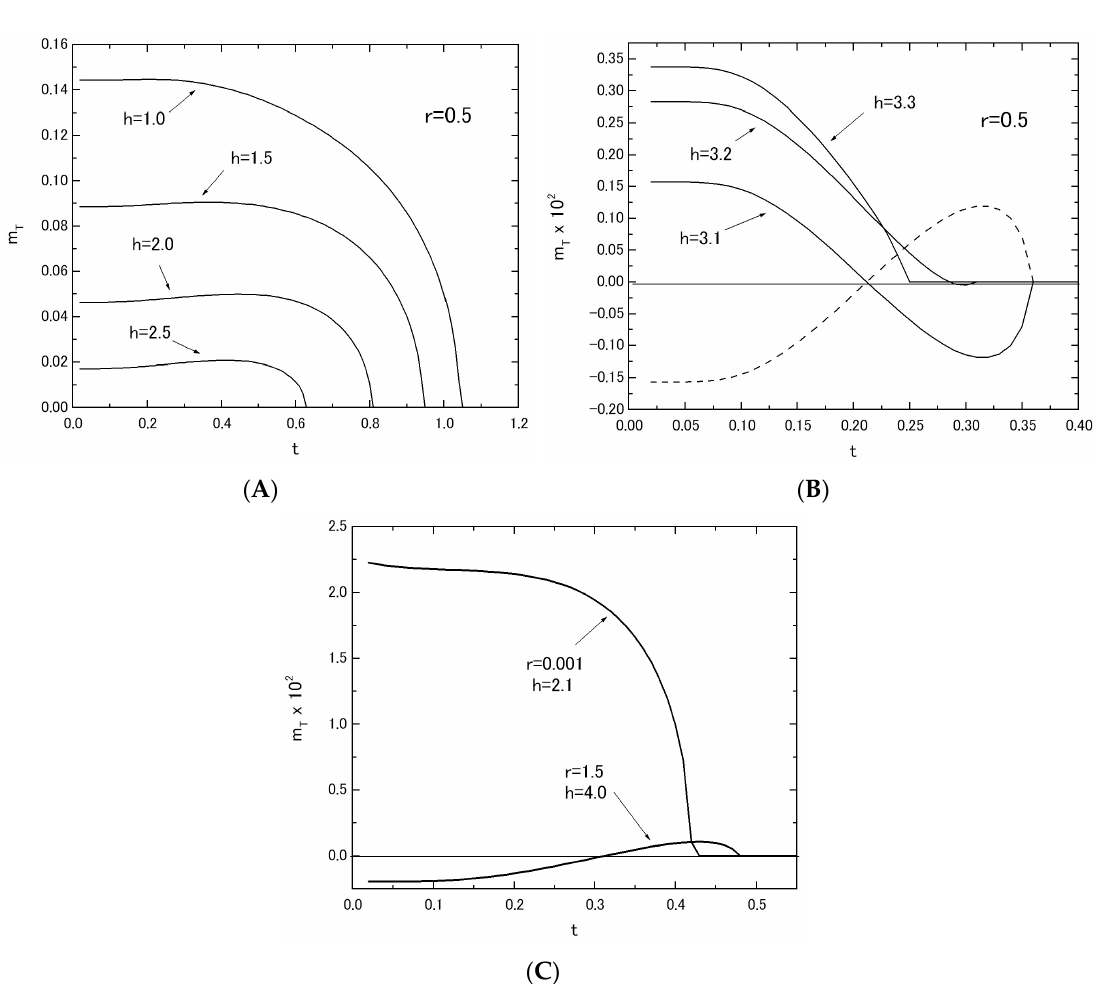
Figure 4. The temperature dependences of m T in the system A; the value of r is fixed at r = 0.5 ( A , B ). The value of h is changed from h = 1.0 to h = 2.5 in ( A ) and from h = 3.1 to h = 3.3 in ( B ). The dashed curve represents the result of the system with r = 0.5 and h = 3.1, when the signs of m A and m B are changed from the case of ( m A > 0.0, m B < 0.0) to the case of ( m A < 0.0, m B > 0.0). The thermal variations of m T are given, when the two set values ( r and h ) are selected as ( r = 0.001 and h = 2.1) and ( r = 1.5 and h = 4.0) ( C ).